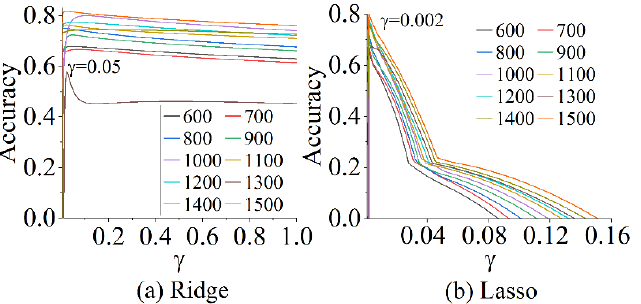
Figure 12. Curves of the accuracy of measuring A and f with γ under different lengths of SMI signals. ( a ) Accuracy changes with γ on ridge. ( b ) Accuracy changes with γ on lasso.